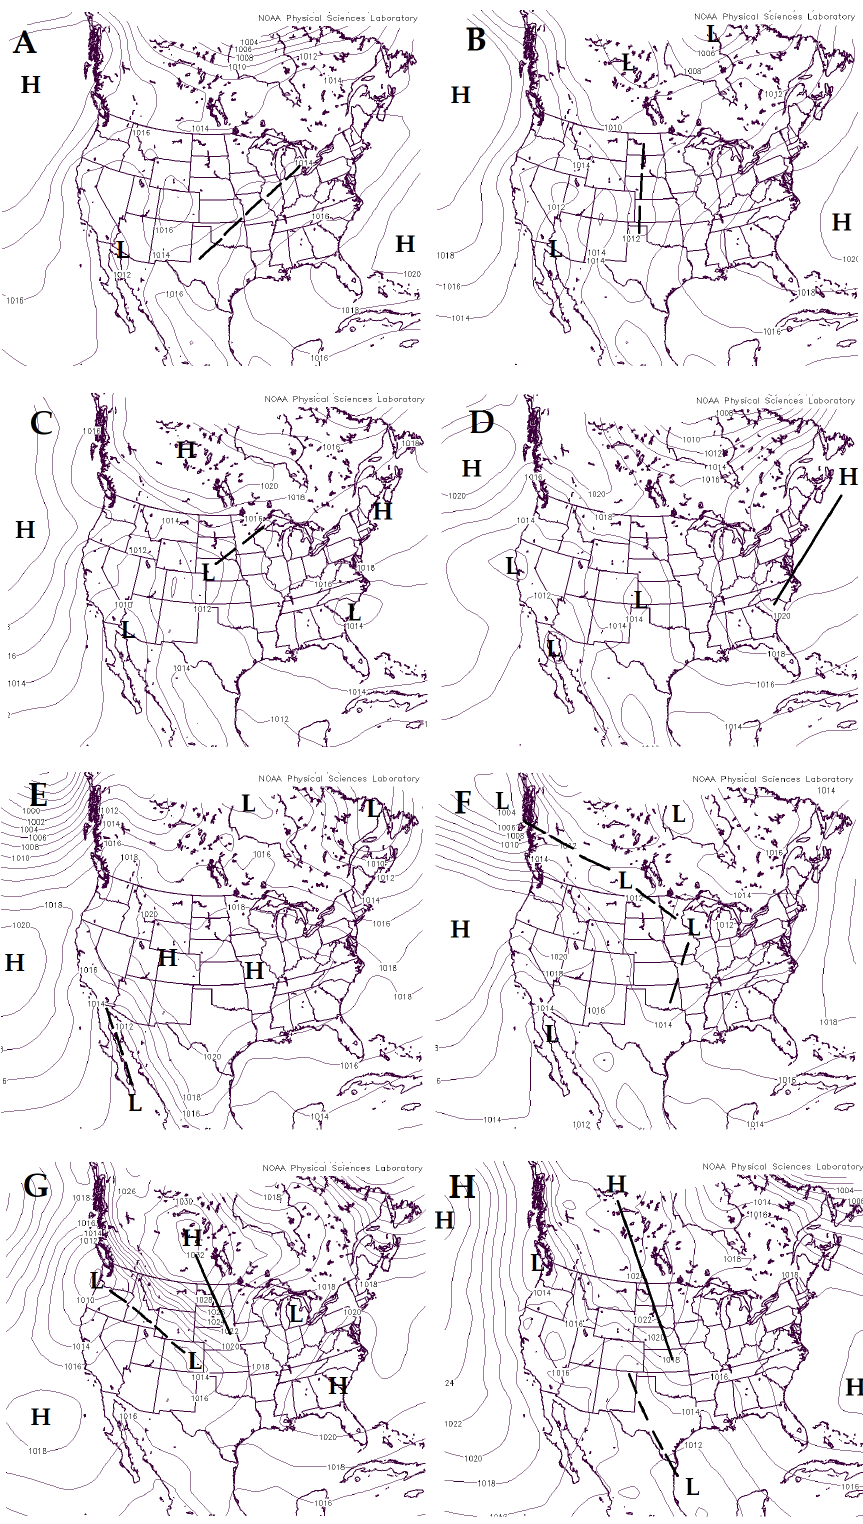
Figure 6. The Sea Level Pressure (hPa) for North America for the 10 days prior to an observed IE maximum; ( A ) 21 August, 2018, ( C ) 23 September, 2018, ( E ) 27 October, 2018, and ( G ) 14 February, 2019, and the 10 days following the IE maximum date for ( B ) case one, ( D ) case two, ( F ) case three, and ( H ) case four. The contour interval is 2 hPa. The H and L are sea level pressure centers, while the dashed (solid) lines are troughs (ridges) of low (high) pressure regions. Table 4. The date of an observed NH IE maximum. Moreover, the major NH teleconnection indexes (PDO/NAO/AO), and the temperature (T °C) and precipitation (mm) character for Saint Louis, Missouri (MO) (STL), Columbia, MO (COU), Kansas City, MO (EAX), and Springfield, MO (SGF) for the ten days before and after the observed IE maximum. The temperature anomalies and the monthly standard deviation ( σ ) relative to the 1981–2010 means are also listed (see: [54]).